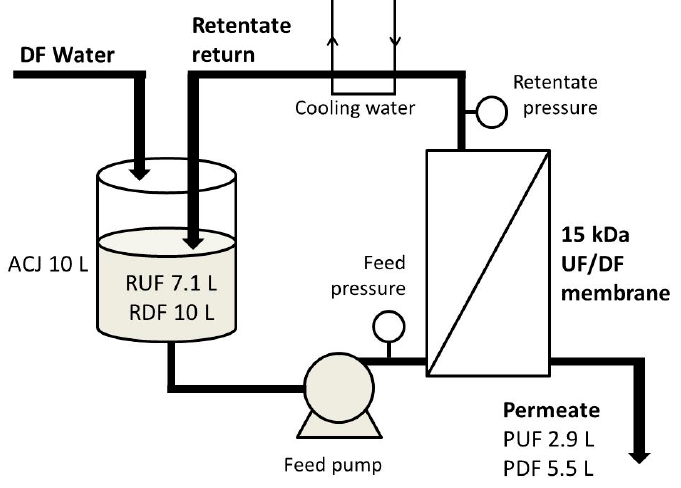
Figure 1. Schematic diagram of the installation used for ultrafiltration (UF) and diafiltration (DF) of cloudy apple-cranberry juice.